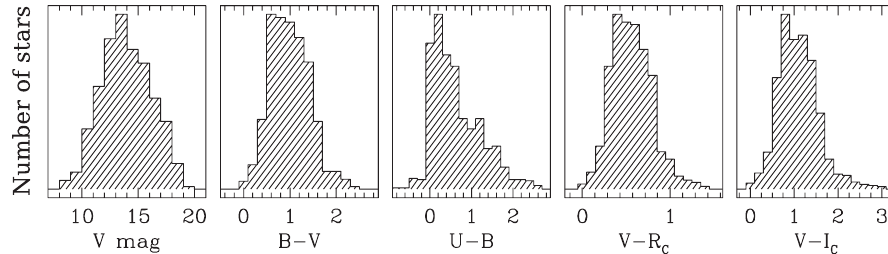
Fig. 2. Distribution in magnitude and color of the 912 Henden & Munari (2000, 2001, 2006) photometric standards around 81 symbiotic